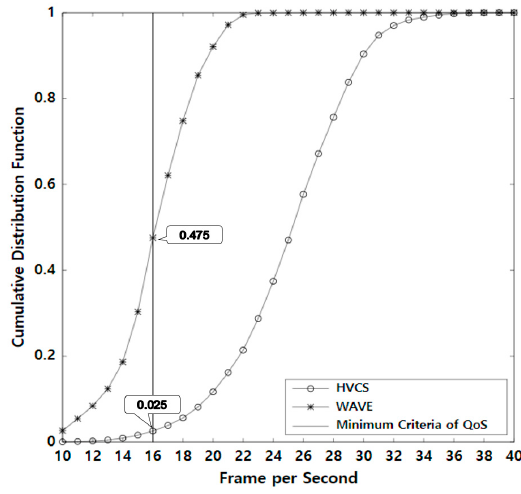
Figure 12. Quality of service level for the video streaming service.